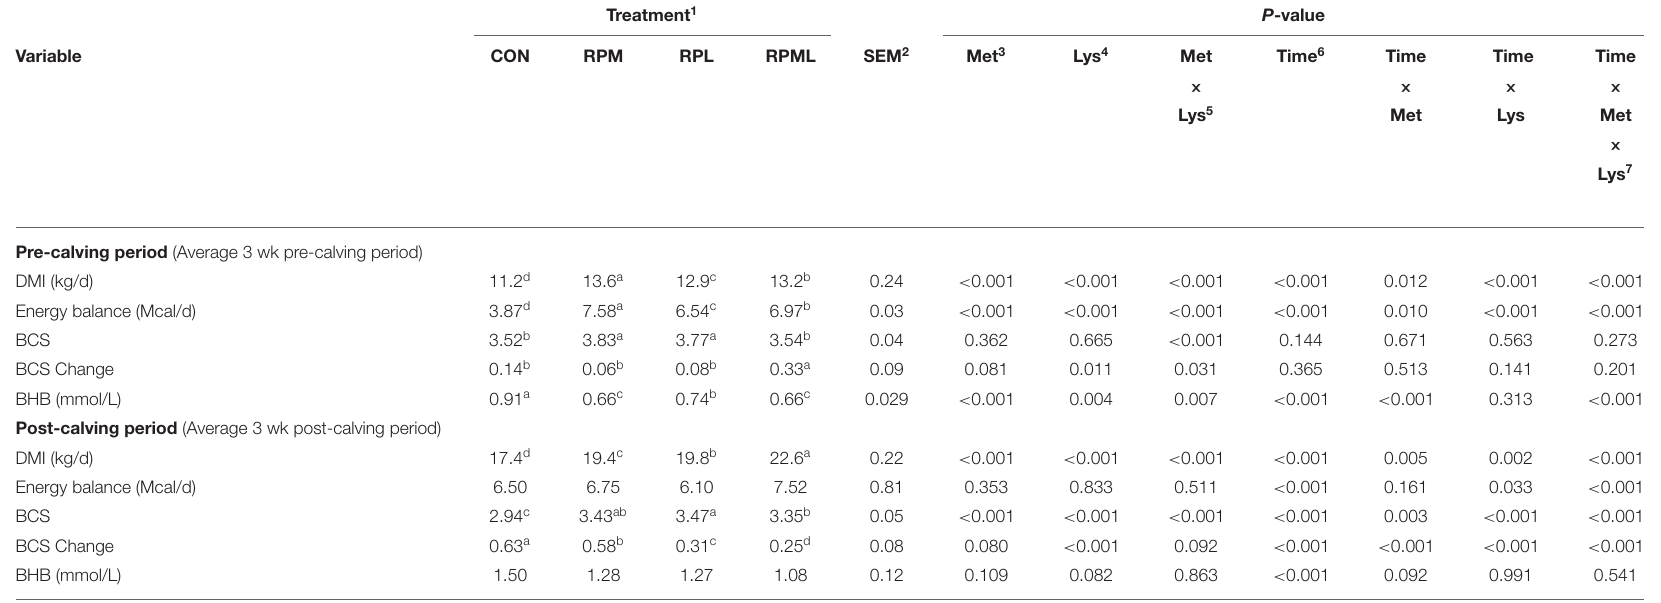
TABLE 4 | Effect of supplementation of ruminally protected Met and Lys on DMI, BCS, Energy Balance, and BHB of Holstein cows during the transition